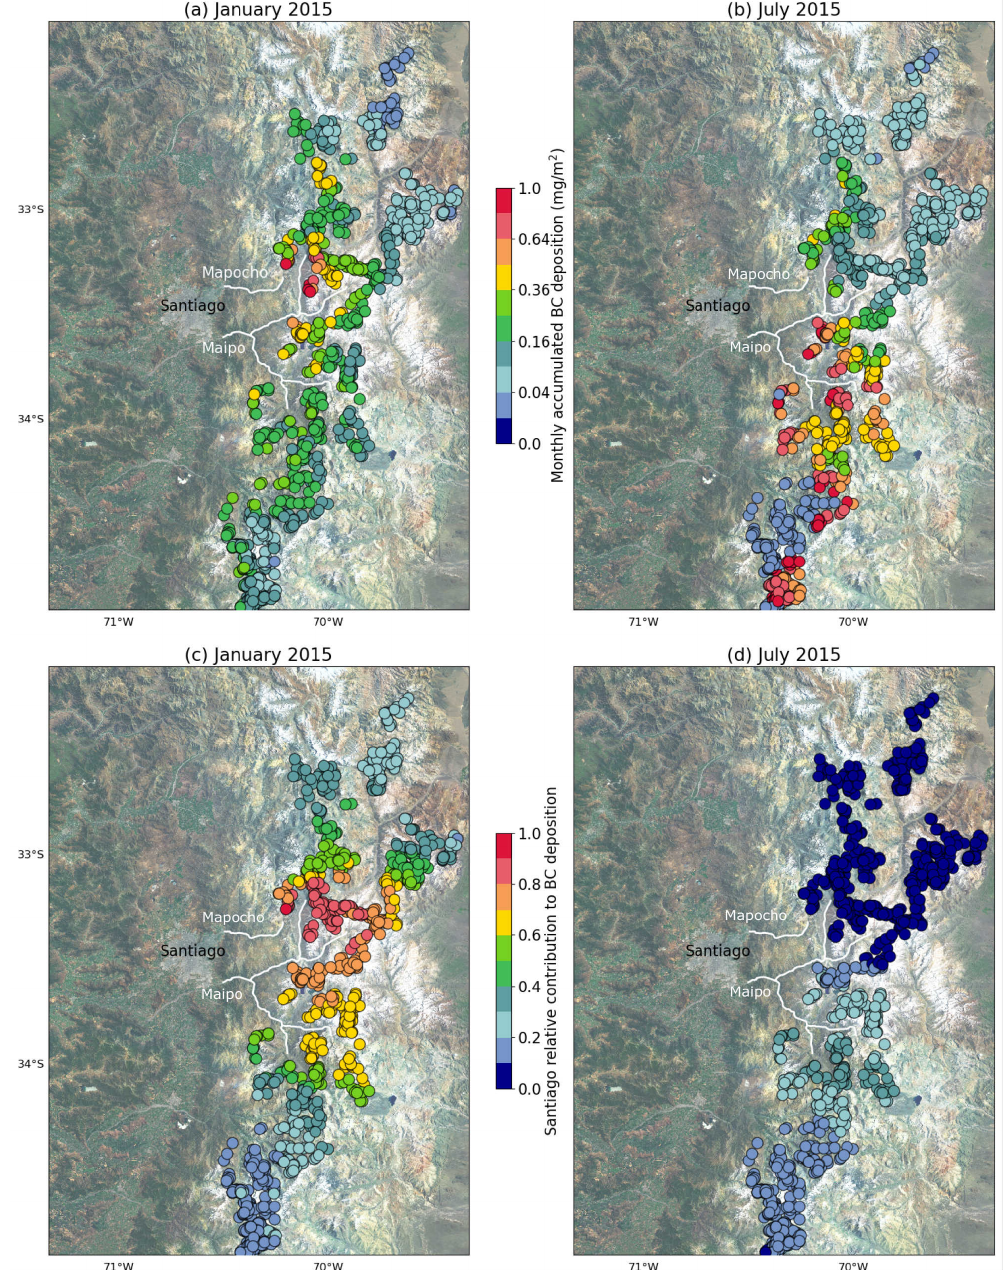
Figure 3. (a) Monthly accumulated BC deposition on glaciers (colored circles) for January 2015. Panel (b) same as (a) for July 2015. (c) Relative contribution of emissions from Santiago to accumulated BC deposition on glaciers for January 2015. Panel (d) same as (c) for July 2015. White lines indicate the main canyons connecting Santiago to the glaciers. Map background layer: Imagery World 2D, © 2009